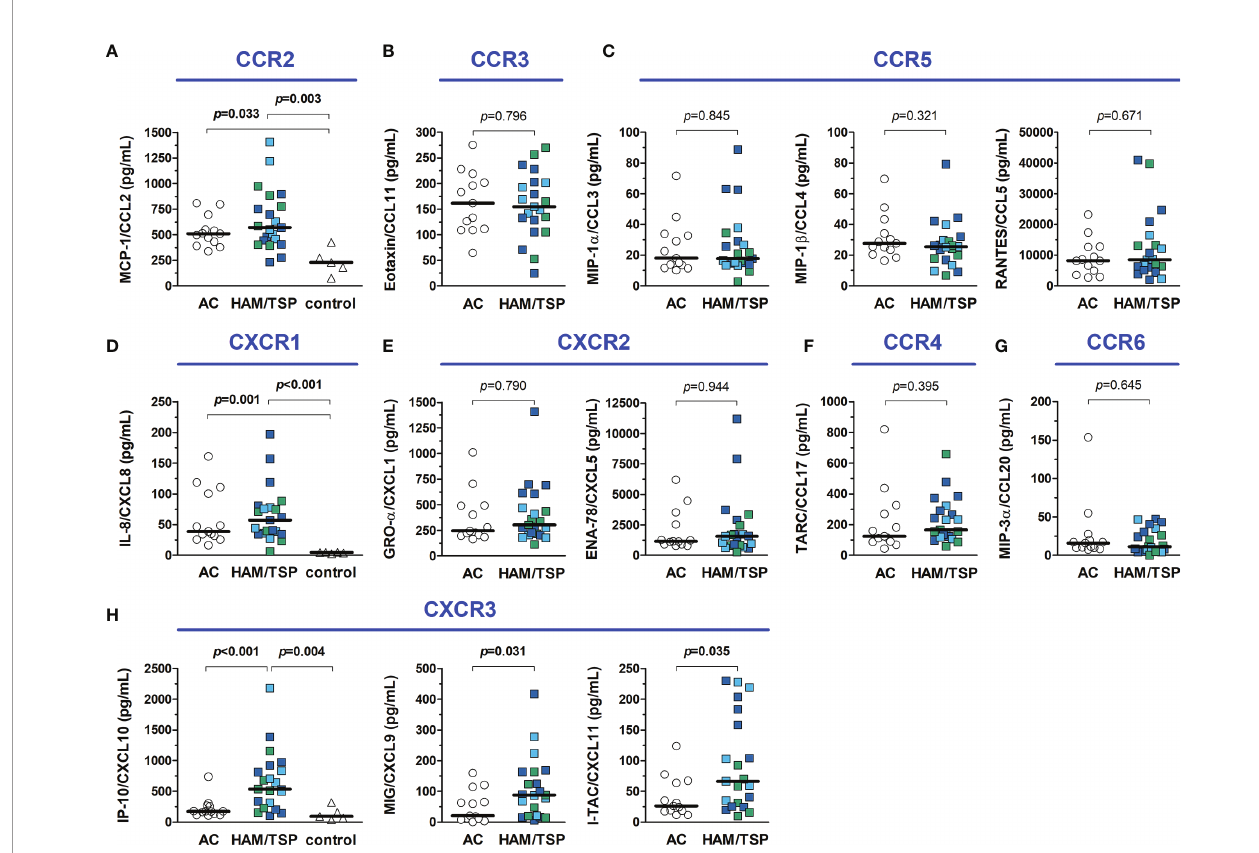
FIGURE 5 | In fl ammatory chemokines in the serum of HTLV-1 asymptomatic carriers (AC) and HAM/TSP patients. Chemokines were quanti fi ed with a multiplex cytometry bead-based immunoassay, and graphs were organized according to their respective receptors, shown in blue. (A) CCL2 (B) , CCL11, (C) CCL3, CCL4 and CCL5, (D) CXCL8, (E) CXCL1 and CXCL5, (F) CCL17, (G) CCL20, and (H) CXCL9, CXCL10 and CXCL11. HAM/TSP patients were identi fi ed according to the speed of disease progression as very slow (light blue), typical/slow (dark blue) and rapid (green). Comparisons between two groups were performed with Mann-Whitney